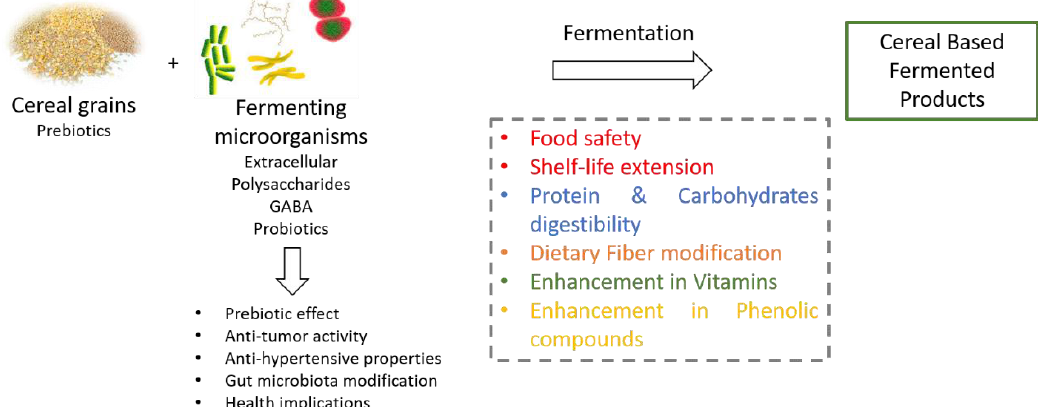
Figure 2. Schematic diagram of the main effects of fermentation on cereal-based products.